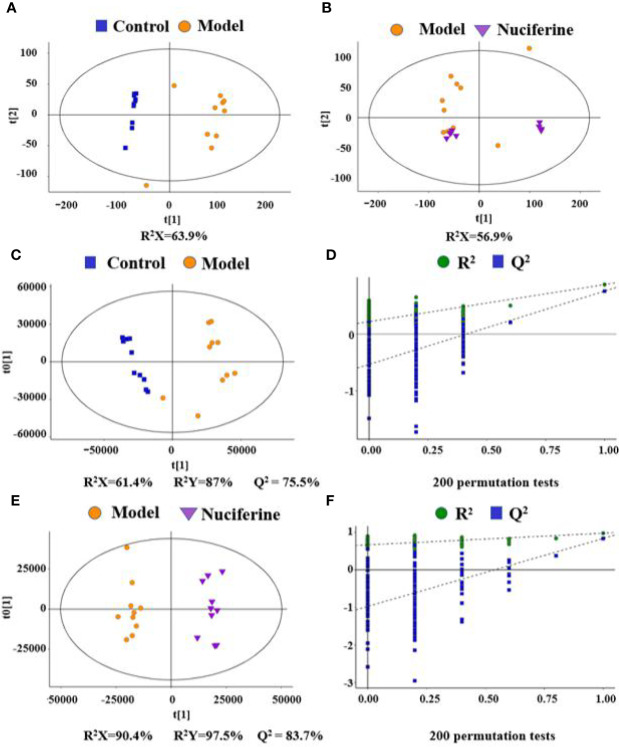
Variable analysis of the metabolomics data in each group. (A, B) Score plots of PCA between the control group and the experimental model group and the experimental model group and the nuciferine-treated group; (C, D) Score plots of OPLS-DA between the control group and the experimental model group and the corresponding coefficient of loading plots; (E, F) Score plots of OPLS-DA between the experimental model group and the nuciferine-treated group and the corresponding coefficient of loading plots. Control, experimental model, and nuciferine-treated (n = 10 per group) groups.